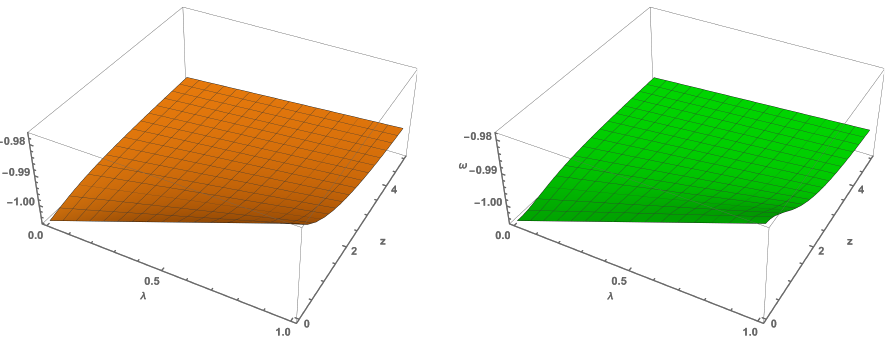
Figure 5. The behavior of energy conditions against the redshift parameter z with the constraint values of the coefficients in (29) λ = 1 and α = − 0.5 for f ( Q ) = α Q .